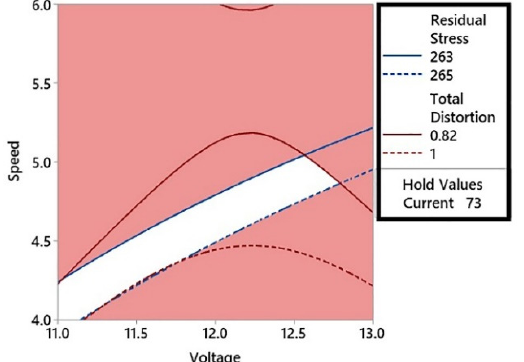
Figure 9. The overlaid contour plot of the total distortion and residual stress with the current at 73 A.